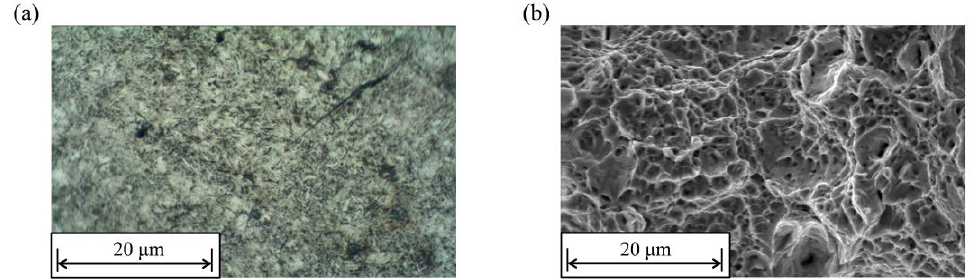
Figure 1. ( a ) Microstructure of AerMet 100 steel under optical microscope; ( b ) Fractography of AerMet 100 steel at magnification rates of 1000 under quasi-static tensile.